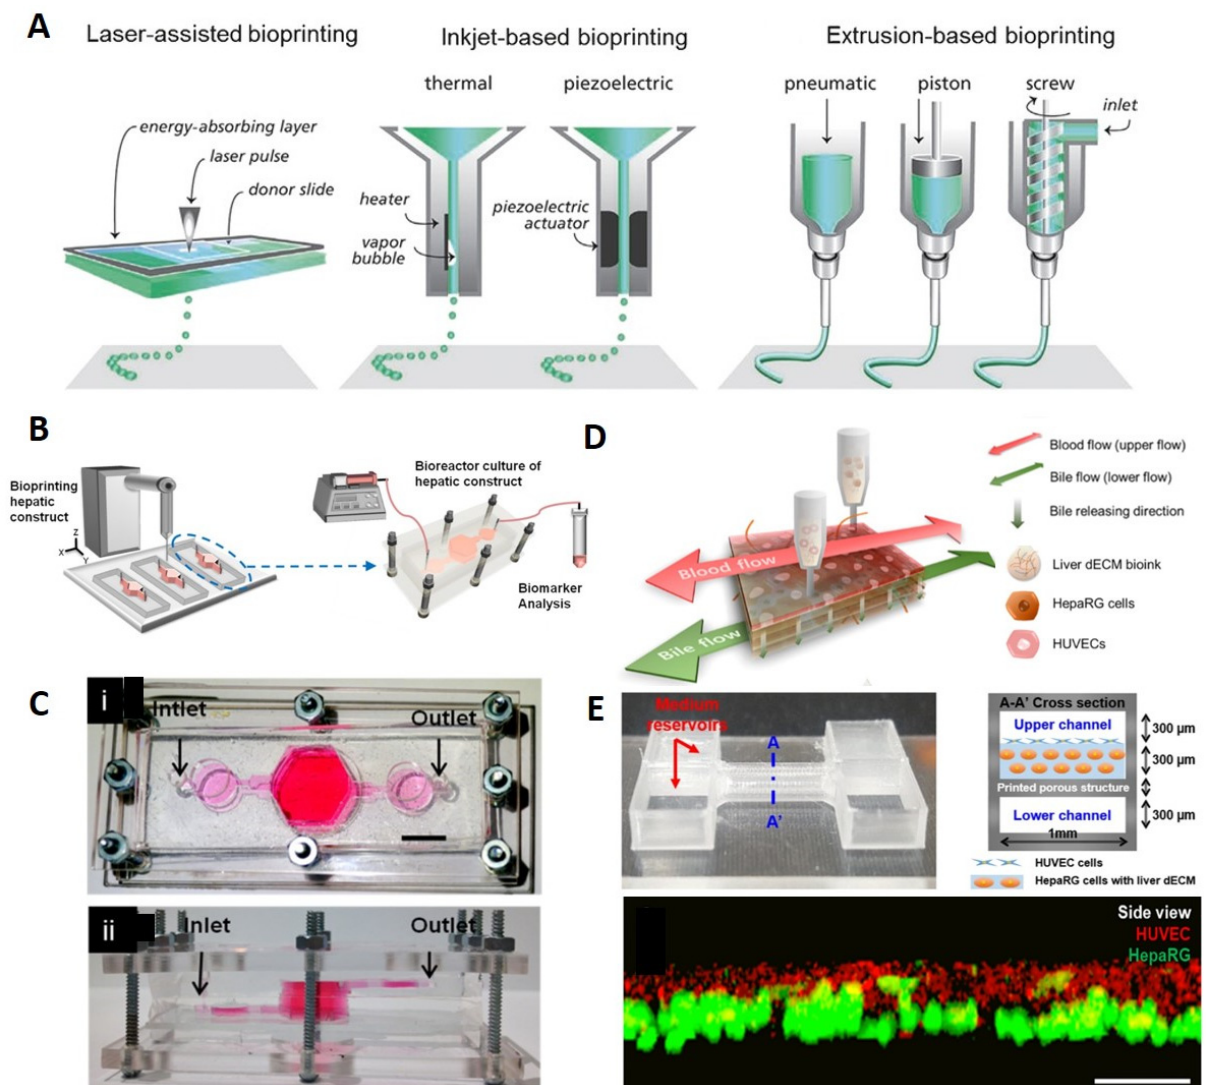
Figure 1. Three-dimensional bioprinting. ( A ) Different 3D bioprinting methods. Reproduced with permission from [8]. 2016, Wiley-VCH Verlag GmbH & Co. KGaA, Weinheim. ( B ) Schematic representation of liver-on-chip 3D bioprinting to form a bioreactor with continuous perfusion for long- term cell culture. ( C ) Implemented liver chip comprised of PDMS and PMMA layers, compressed by nuts and screws to enable disassembly of the setup for examining cell culture anytime [75] . ( B , C ) Reproduced with permission from [75] . 2016, IOP publishing Ltd. ( D ) Schematic view of a single-step 3D bioprinting of a liver-on-chip platform with vascular/biliary channels to supply nutrients and remove waste products to enhance cell proliferation and survival. ( E ) (Top) View of the microfluidic chip and its cross-section. The chip contained two upper and lower channels with a 3D bioprinted microporous membrane. HepaRG liver decellularized extracellular matrix (dECM) bioink was printed on the micromembrane. (Bottom) The evaluation of cell positioning after cell printing on the microporous membrane, demonstrating a successful bioink printing (scale bar: 100 μ m) [71] . ( D , E ) Reproduced with permission from [71] . 2019, IOP publishing Ltd.